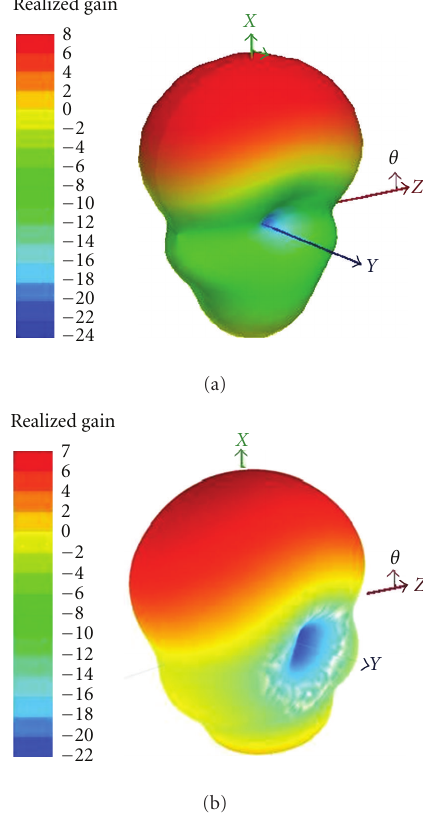
Figure 8: Simulated (a) and measured (b) 3D radiation pattern of the dipole antenna with reflector and director.